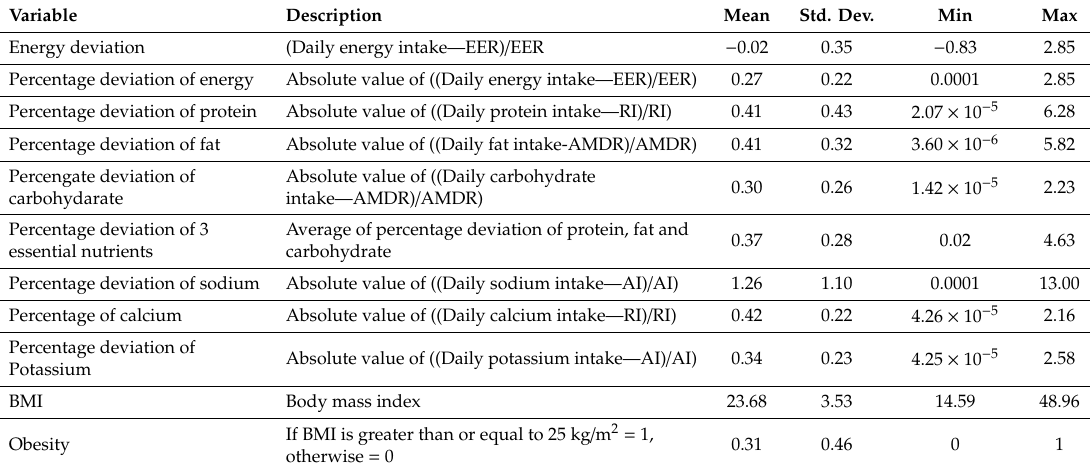
Table 2. Descriptive statistics of outcome variables.